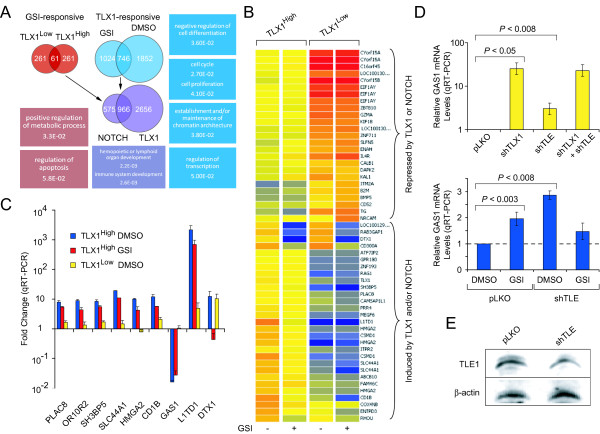
TLX1 and NOTCH coregulate transcription. (A) ALL-SIL cells were treated for 24 hours with 500 nM Compound E (GSI) and 0.05% DMSO as vehicle control and then harvested for microarray analysis. The Venn diagrams indicate a significant overlap between TLX1 targets and GSI-responsive genes (P < 0.0001; data for a 10% FDR is shown). GO terms uniquely associated with the overlapping genes in each pair-wise comparison are indicated (see text for details). (B) Hierarchical clustering of known genes showing > 2-fold change under TLX1High versus TLX1Low conditions and a FDR < 10%. (C) Confirmation by qRT-PCR of representative coregulated genes. Data is normalized to TLX1Low GSI-treated samples, where both NOTCH and TLX1 are downregulated. The average of 3 experiments is shown (P values are indicated in the text where discussed and the P values for all comparisons are provided in Additional file 4; n = 3 biological replicates, each comprising 3 technical replicates). (D) TLX1 and NOTCH repress the GAS1 gene via a TLE corepressor-mediated mechanism. Top, ALL-SIL cells expressing the TX1 shRNA95 or pLKO control vector were transduced with lentiviral vectors expressing panTLE shRNAs. Bottom, ALL-SIL cells expressing the pLKO control vector were transduced with lentiviral vectors expressing panTLE shRNAs. GSI treatment was for 24 hours. (E) Western blot analysis showing 50% reduced TLE1 levels in ALL-SIL cells expressing panTLE shRNAs (P < 0.05).